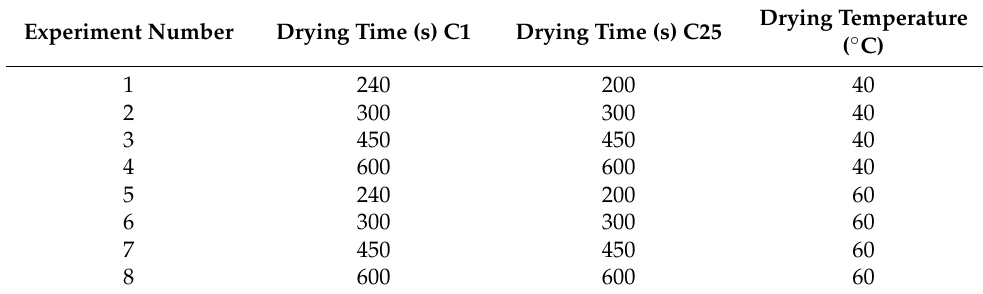
Table 1. Overview of the applied drying